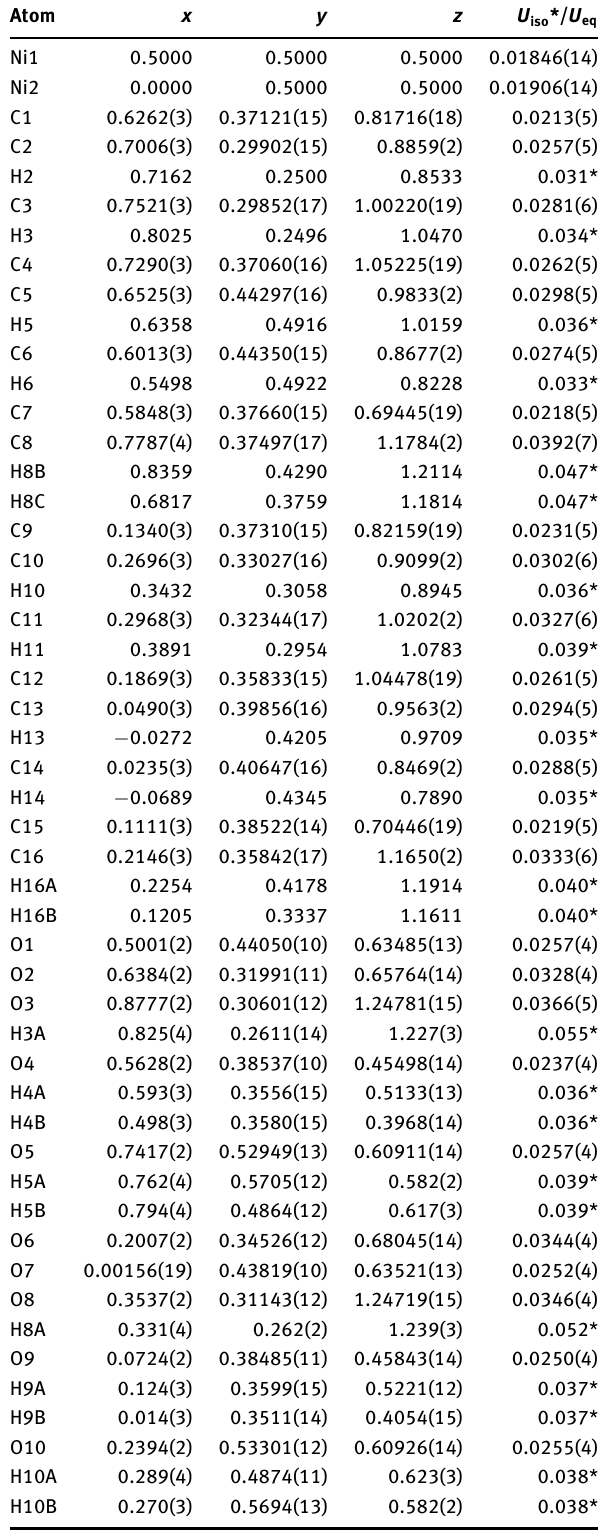
Table 2: Fractional atomic coordinates and isotropic or equivalent isotropic displacement parameters (Å 2